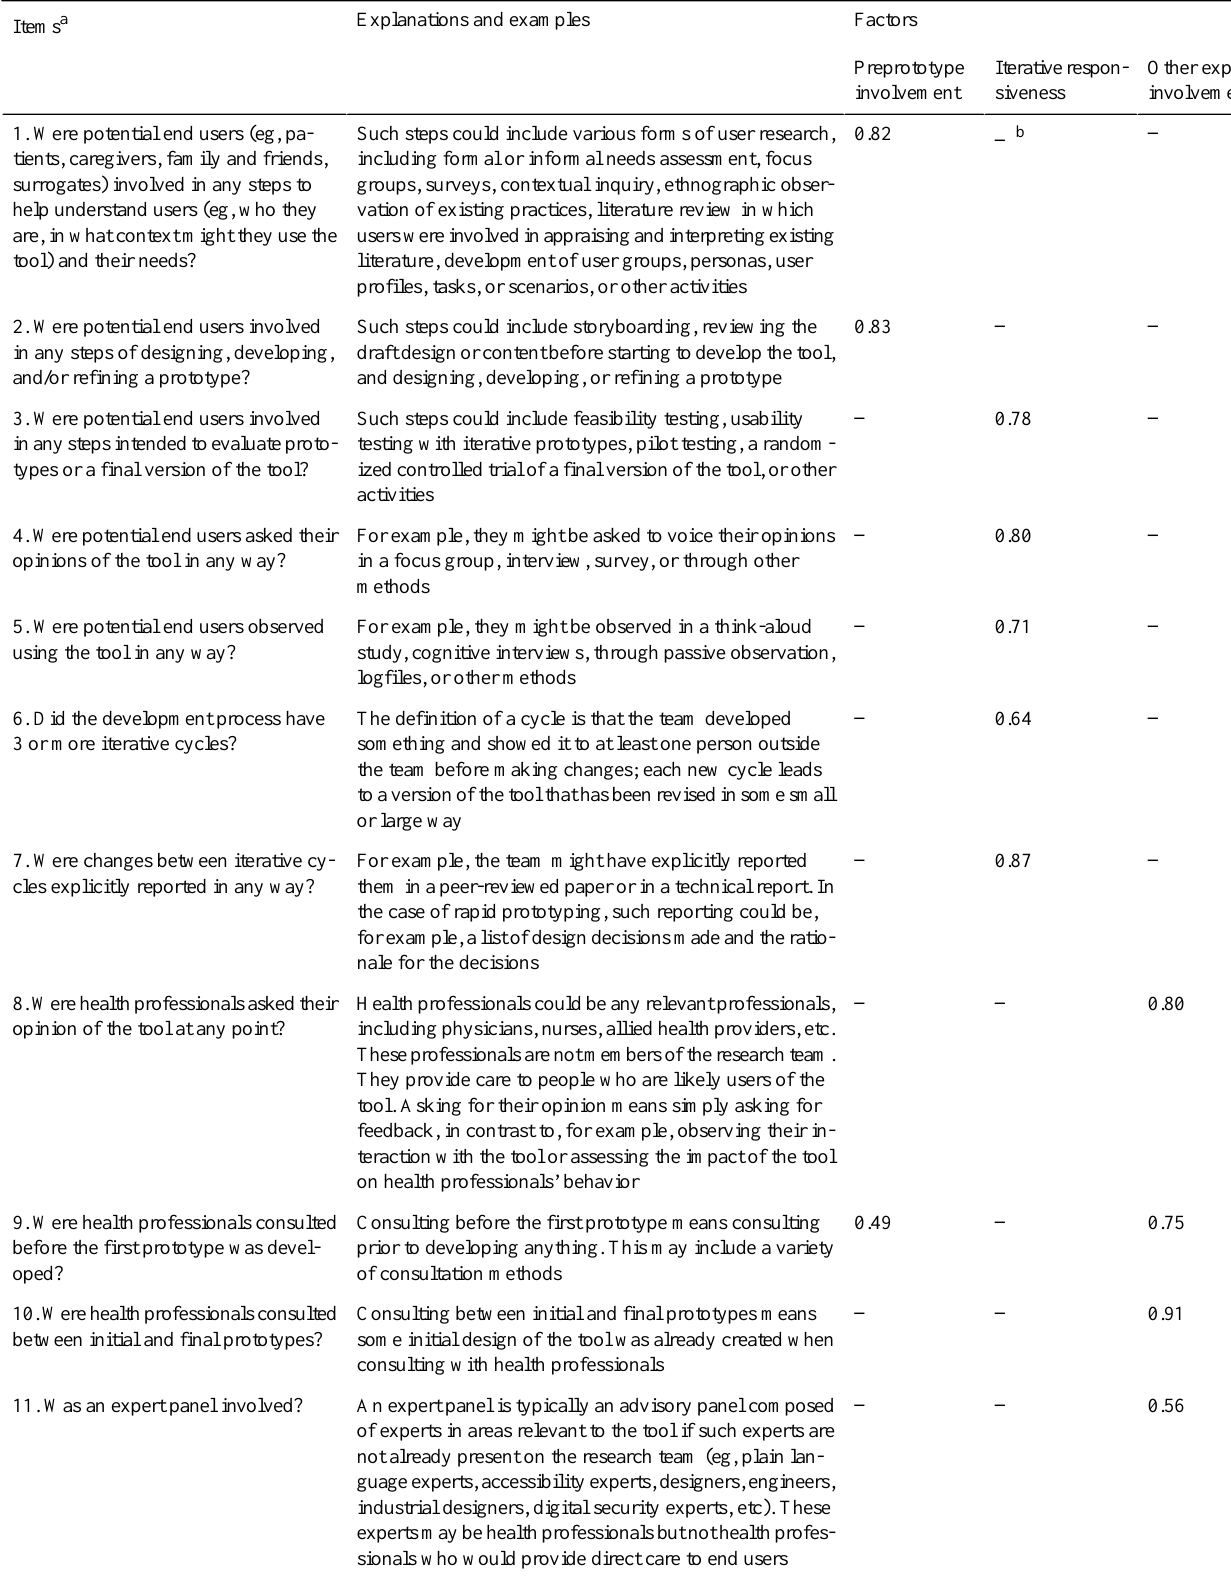
Table 1. Final measure with factor loadings.